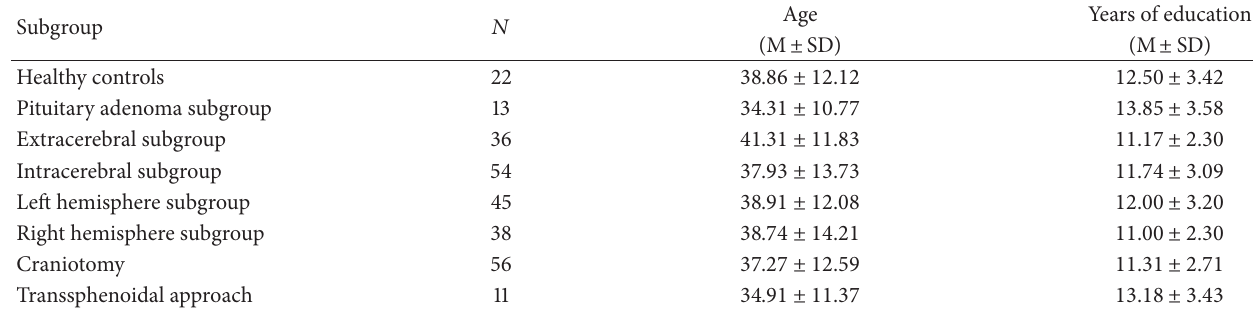
Table 1: Demographic characteristics of all subgroups (M ±